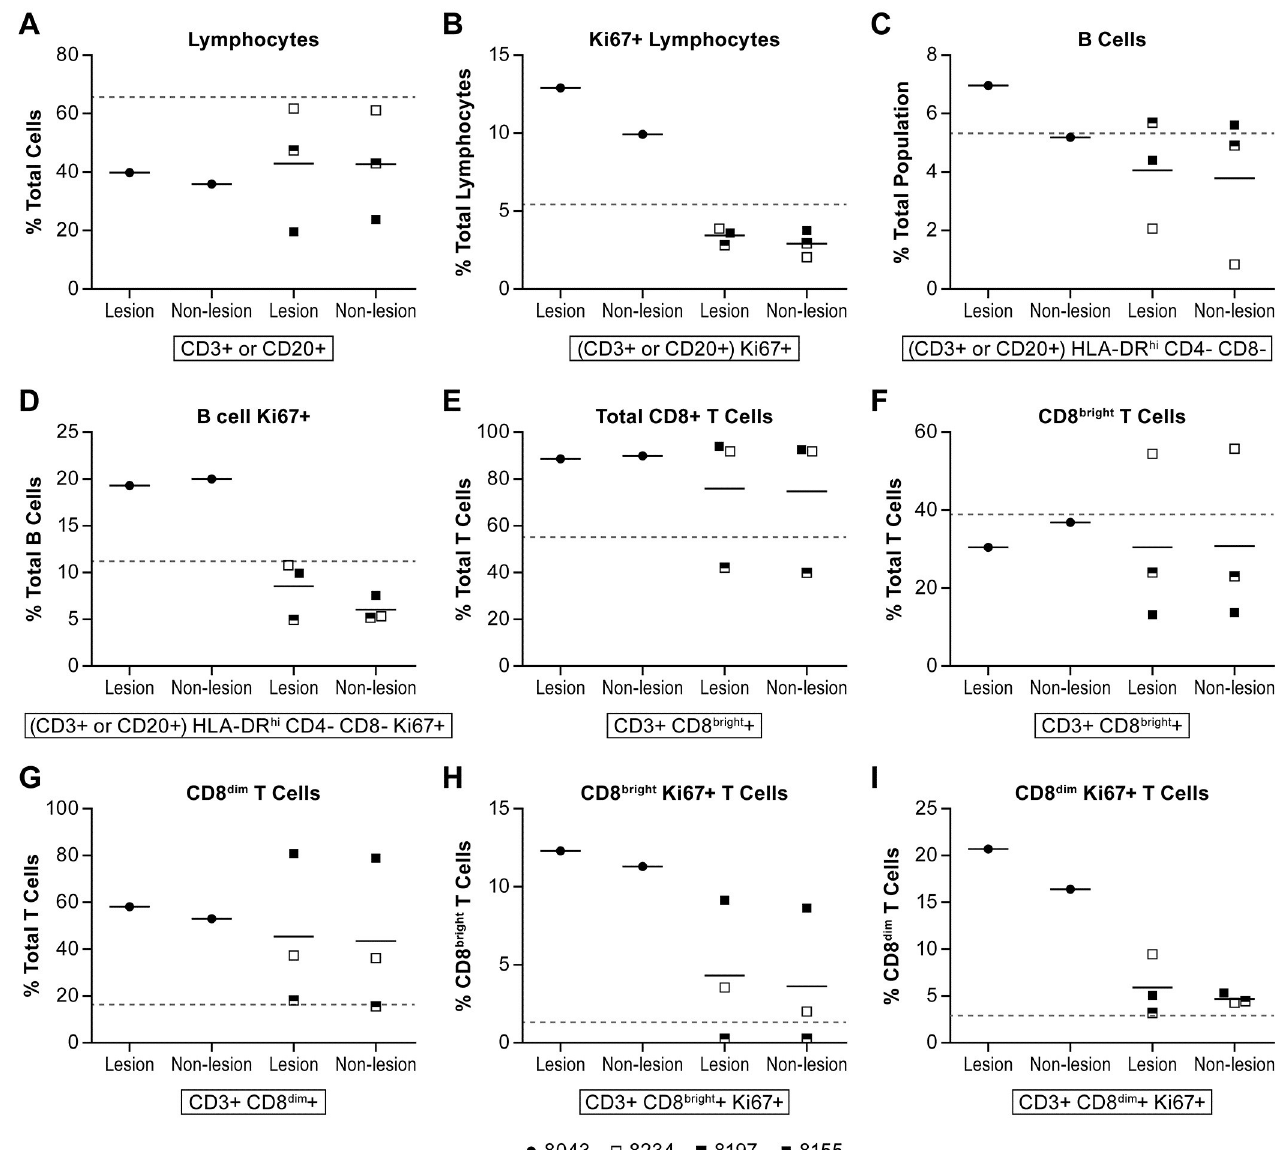
Fig 7. Lymphocyte cell populations in the lung. Flow cytometric analysis for quantification of lymphocytes collected from the lungs of four of six animals following exposure to NiV. Tissues were not collected from two animals due to tissue degradation. For each animal, samples from apparently unaffected tissue (non-lesion) and affected tissue (lesion) were collected. The specific markers used to distinguish lymphocytes are indicated below the individual panels. Analyses included the Ki67 marker to determine if cell populations were proliferating. Animals included in this analysis included 8043 (filled circle), 8234 (open square), 8197 (half filled square) and 8155 (filled square). Individual cell populations included (A) lymphocytes; (B) proliferating lymphocytes; (C) B cells; (D) proliferating B cells; (E) total CD8+ T cells; (F) CD8 bright T cells; (G) CD8 dim T cells; (H) proliferating CD8 bright T cells; and (I) proliferating CD8 dim T cells. Markers and antibody clones used for these analyses can be found in S3 Table. The dashed horizontal line indicates the mean value of equivalent cell populations collected from two control animals. The solid lines represent the mean for that dose group. 7G). In one animal (#8043) both CD8 bright and CD8 dim populations had a high proportion of Ki67+ cells suggesting cell proliferation, while in one animal (#8155) only the CD8 bright popu- lation was proliferating (Fig 7H and 7I). In the convalescent animal, the proportion of Ki67 + CD8+ T cells in the lung was very low.